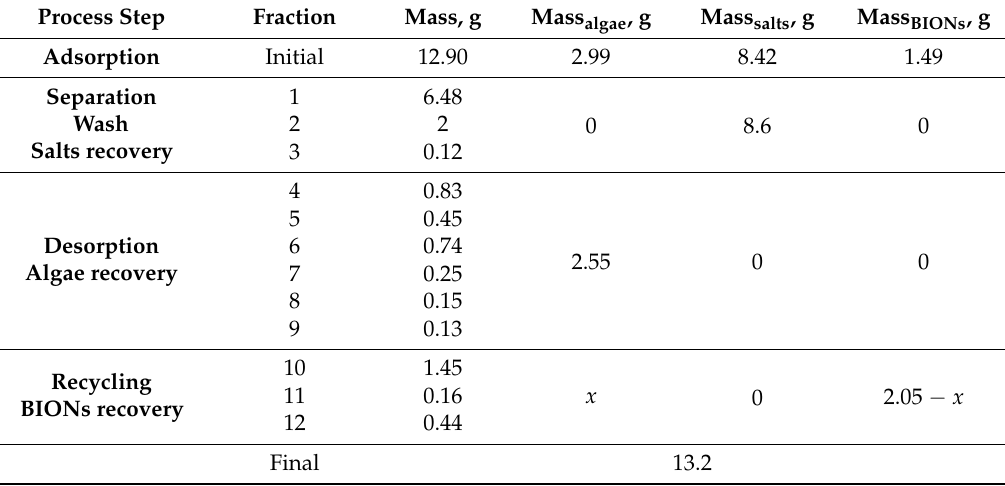
Table 1. Dry mass of the fractions collected as quantified by gravimetry and spectrophotometrically. In the fractions 1–3, no absorbance was detected and therefore their mass should correspond only to the salts. In fractions 4–9, no magnetic material was observed in the samples or collection vessels. Fractions 10–12 mainly contain BIONs, but due to limitations of the quantification methods, identifying the mass of algae in these fractions was not